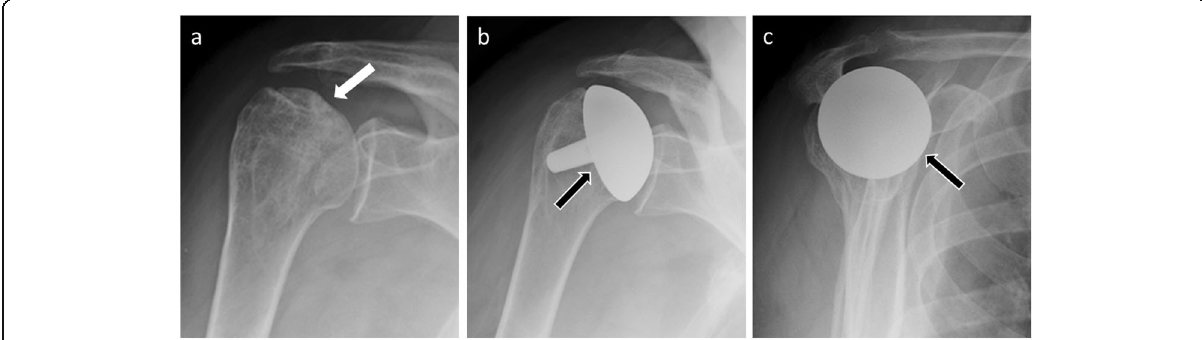
Fig. 5 a Anteroposterior radiograph in a 63-year-old woman shows avascular necrosis of the humeral head (white arrow). Anteroposterior ( b ) and scapular Y ( c ) radiographs of normal findings in the same patient as in a with humeral head resurfacing arthroplasty. The humeral prosthetic head (black arrows) is centered within the native glenoid